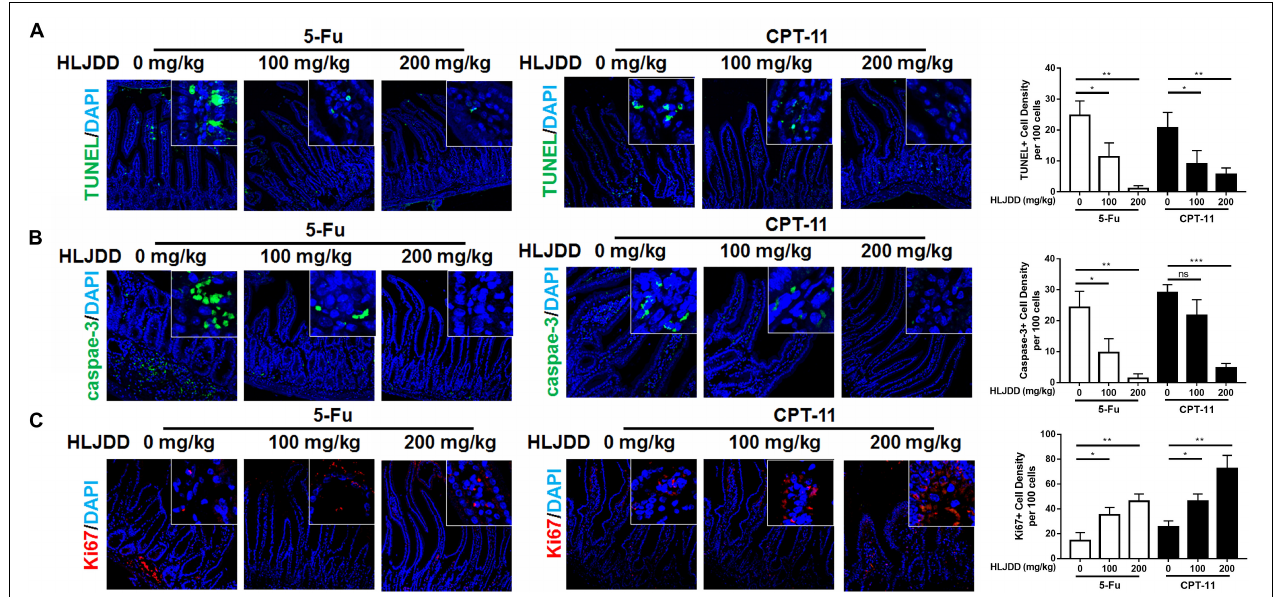
FIGURE 4 | Pre-treatment of HLJDD reduced intestinal cell apoptosis and improved renewal in chemotherapy-treated mice. (A) Showed that pre-treatment of HLJDD could significantly reduce the positive TUNEL signal in the intestinal section of chemotherapy-treated mice; (B) showed that pre-treatment of HLJDD could significantly reduce the expression of cleaved caspases-3 in the intestinal section of chemotherapy-treated mice; (C) showed that pre-treatment of HLJDD could significantly improve the renewal-associated Ki67 expression in the intestinal section of chemotherapy-treated mice. * p < 0.05, ** p < 0.01, *** p < 0.001 when compared with the model